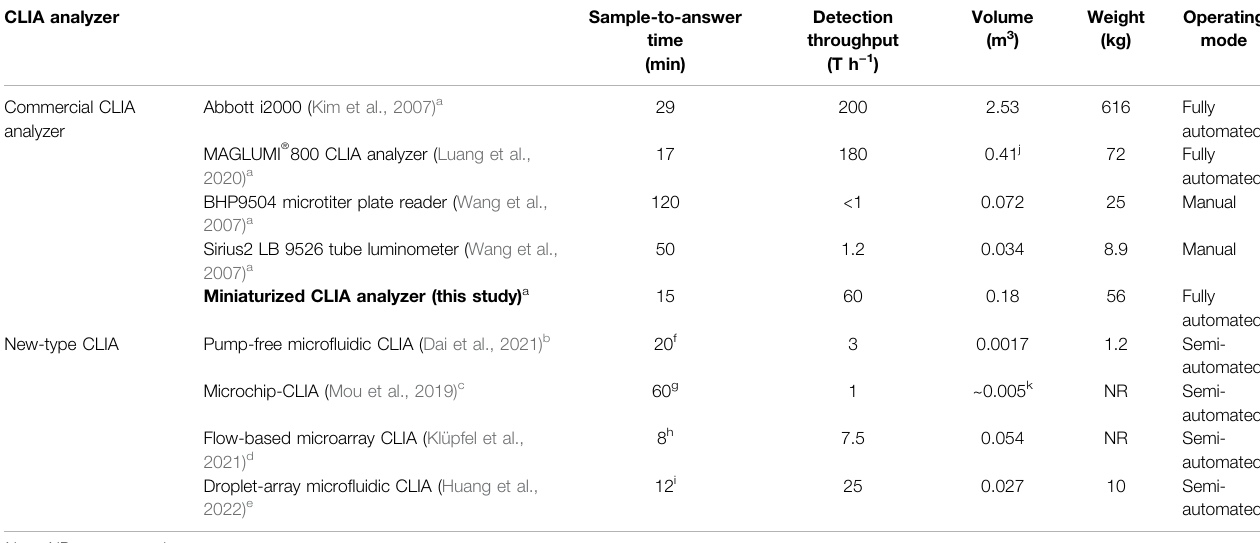
TABLE 4 | Comparison of the existing chemiluminescence immunoassay